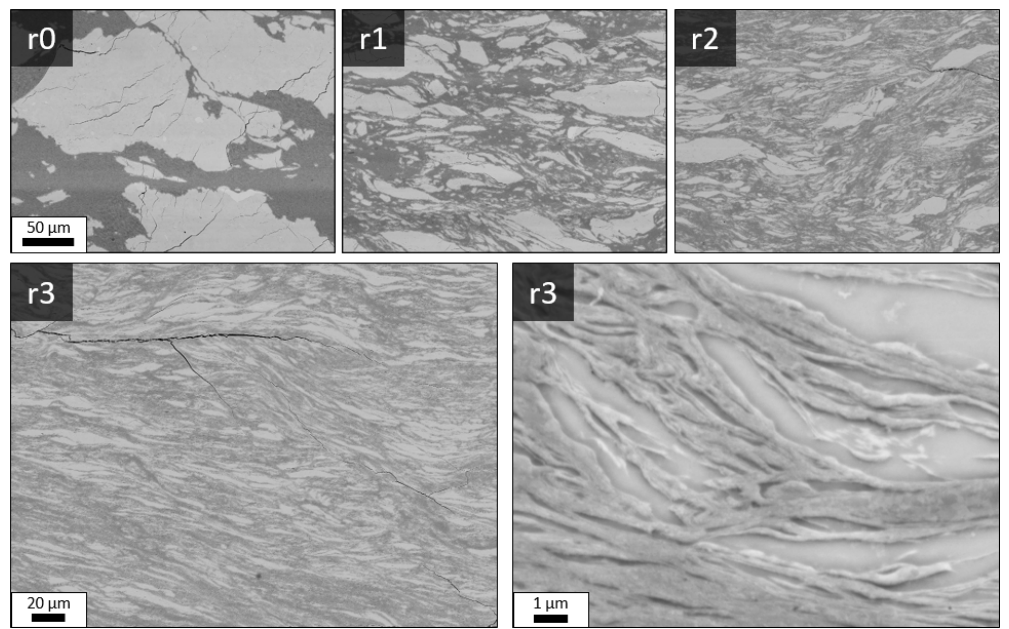
Figure A4. BSE images of a HPT-deformed sample (Nr. 5) at 250 ◦ C consisting of 47 wt.% Fe–53 wt.% SmCo 5 at different radii. The scale bar in r0 also applies to r1 and r2. Images of two magnifications are presented for r3.